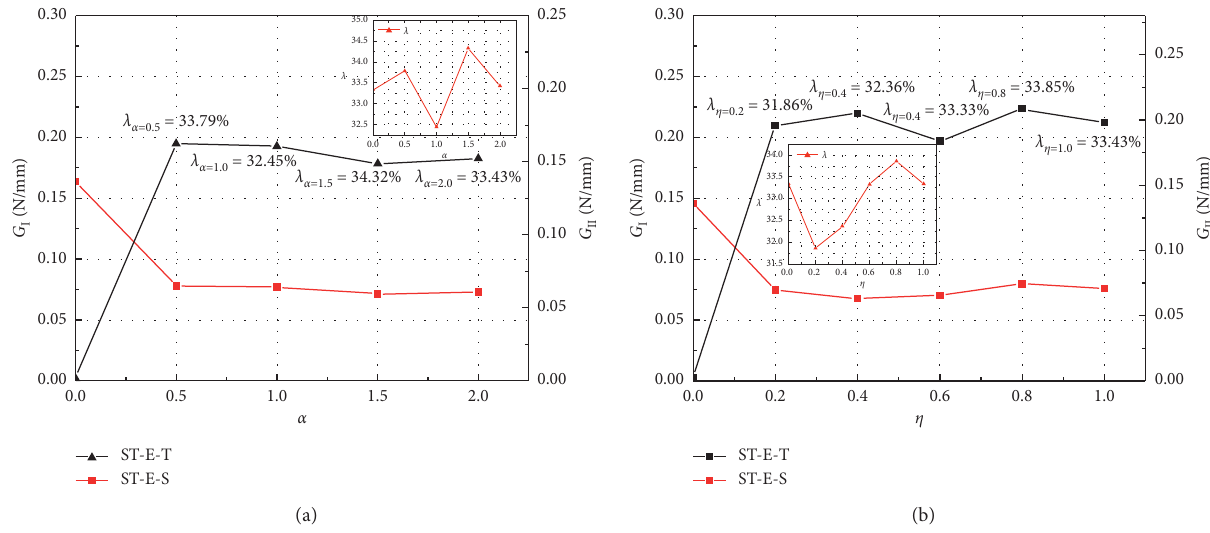
Figure 11: The influence of interface failure criterion and its parameters on interfacial fracture energy. (a) Power law. (b) BK law.